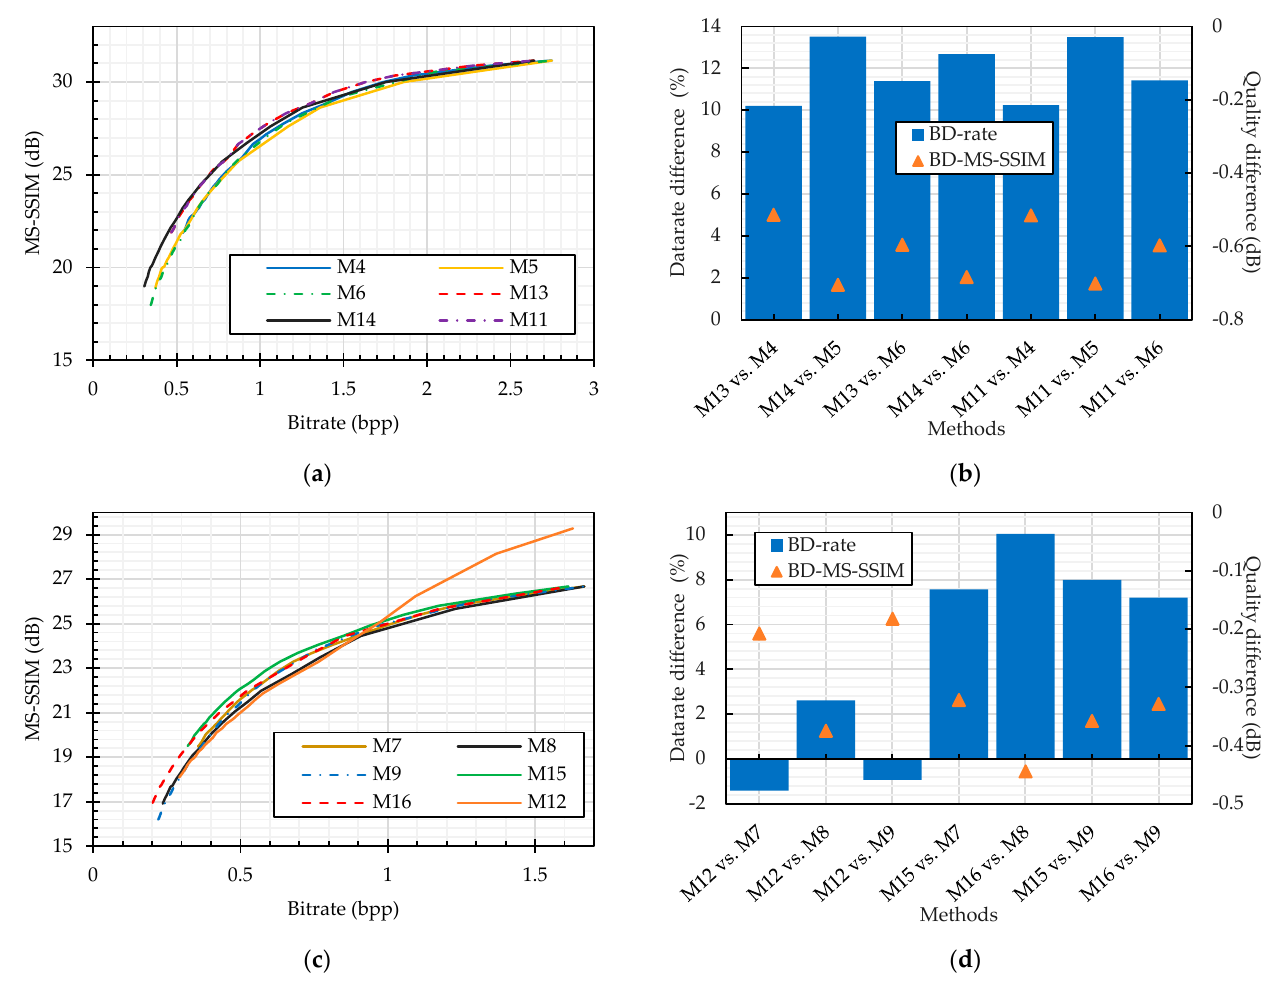
Figure 16. The JPEG compression analysis on plain and PGS–CPE images without and with chroma subsampling in ( a ) and ( c ), respectively; ( b , d ) are their corresponding BD-measures plots.